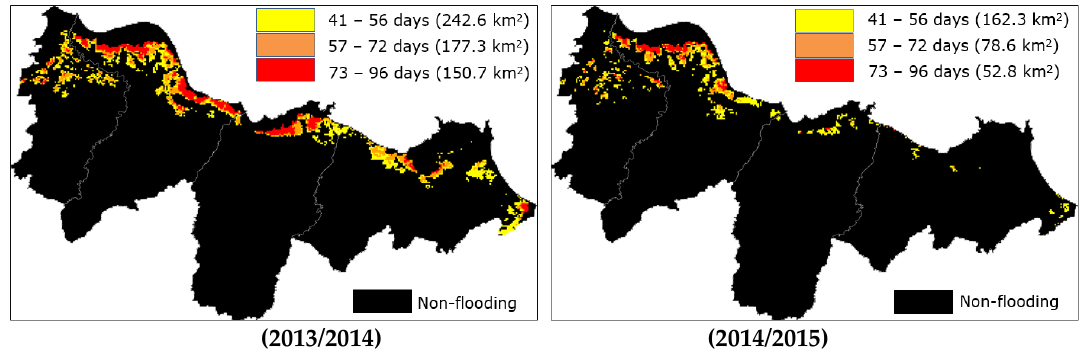
Figure 8. Maps of flood duration generated using EVI40 during wet planting seasons (DOY 1–89) in 2013/2014 and 2014/2015.